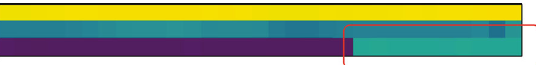
Figure 14: State image visualization for the records in Figure 13; width of the image corresponds to the time window (30s), and the 3 rows (from top to bottom) indicate normalized airspeed, AOA, and sideslip angle, respectively; the sideslip drift fault is marked with a red box.